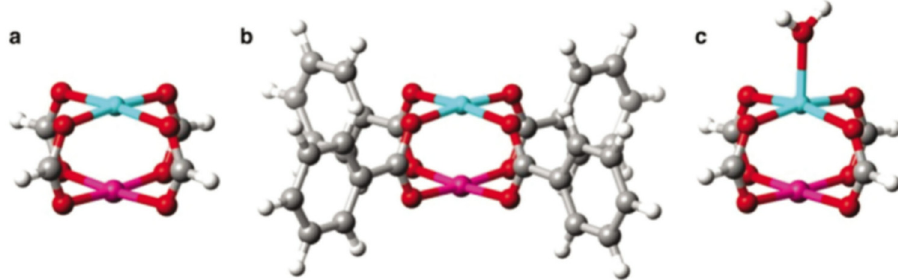
Figure 4: Clusters investigated a unit cell of cuboctahedral bimetallic networks using density functional theory methods: ( a ) formate, ( b ) benzoate, and ( c ) water solvated.